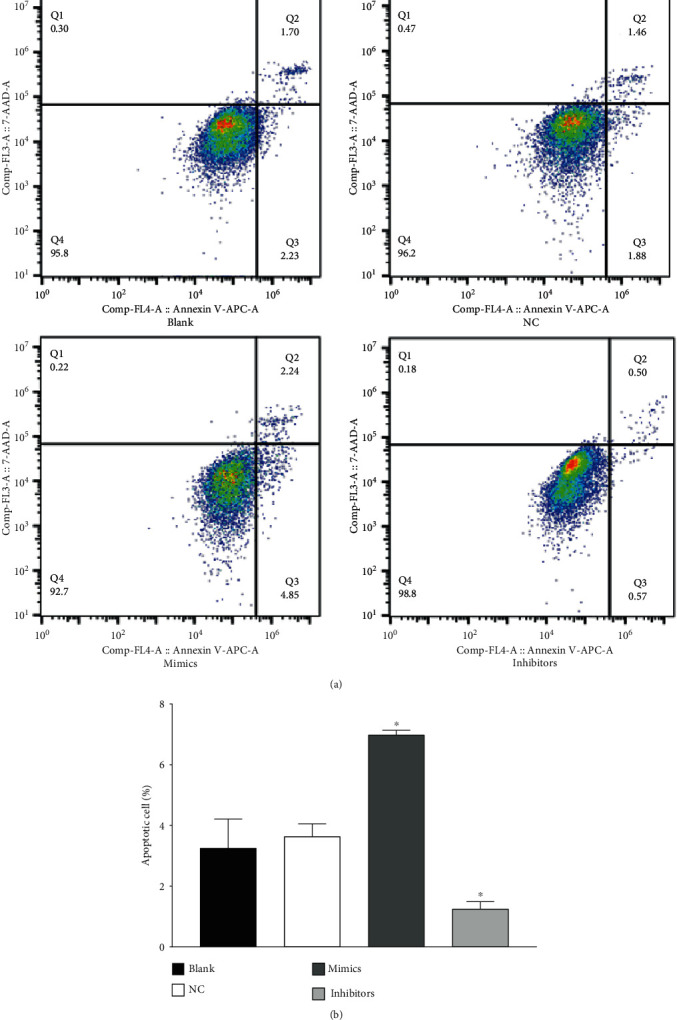
Apoptosis of primary HUVECs induced by transfected miR-499a-3p. (a) The effects of miR-499a-3p on the apoptosis of primary HUVEC determined by flow cytometry. Four groups were tested, including the blank, NC, mimics, and inhibitors groups. (b) Histogram show of the percentage of apoptotic cells in each group.